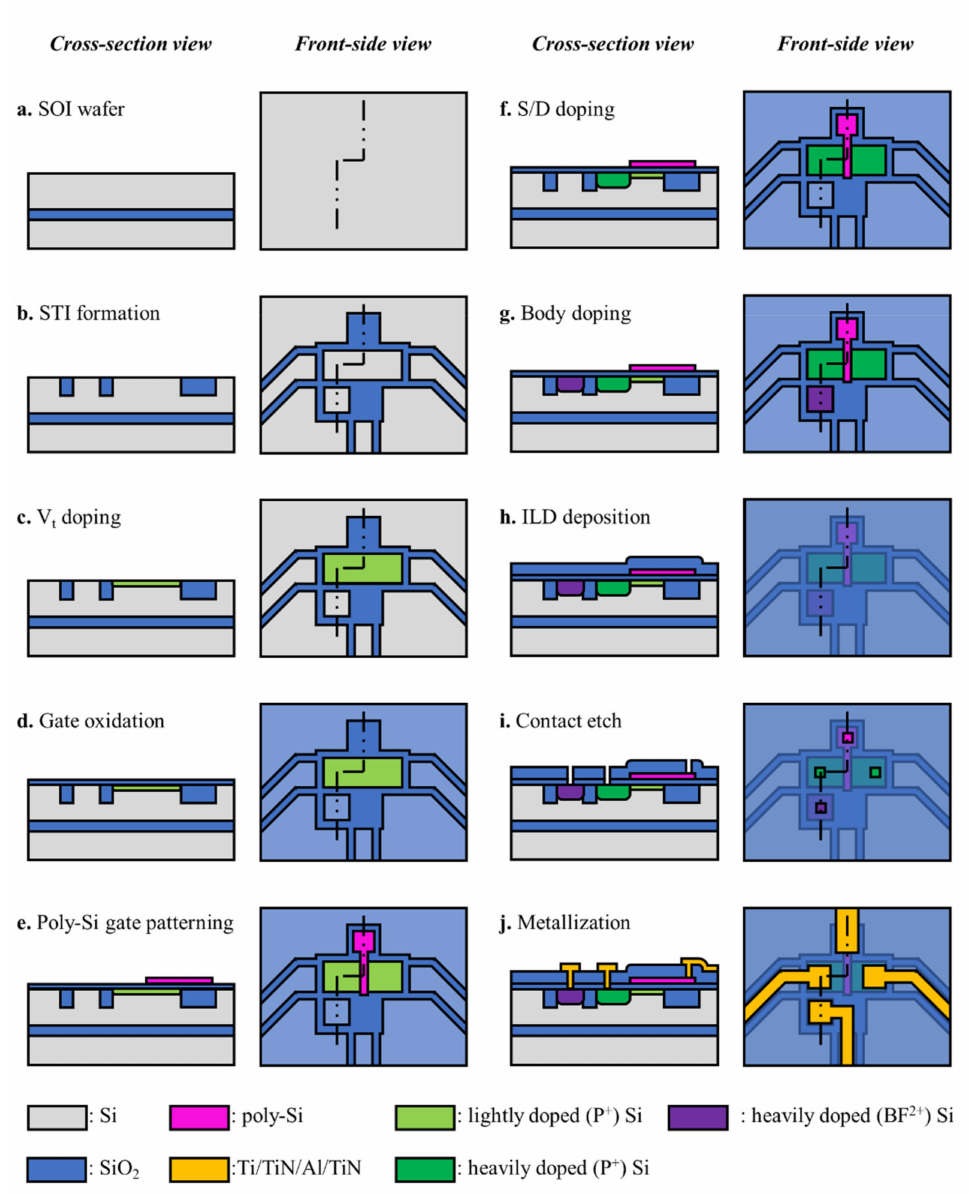
Figure 2. Fabrication of the inbuilt MOSFET: ( a ) The silicon-on-insulator (SOI) wafer was used for Si cantilever fabrication. ( b ) The active area of the device was defined by trench formation. ( c ) The shallow doping was performed to control the threshold voltage. ( d ) 30 nm-thick oxide is grown via oxidation. ( e ) Poly-Si was patterned as a gate. ( f ) Source and drain are heavily doped with P + ions (the poly-Si gate was also doped in this process). ( g ) Body is heavily doped with BF 2+ . ( h ) Inter-layer dielectrics (ILD) was deposited on the entire surface. ( i ) The contact window through the ILD was etched for the electrical connection. ( j ) Metal electrodes (Ti/TiN/Al/TiN) connecting terminals to pads were